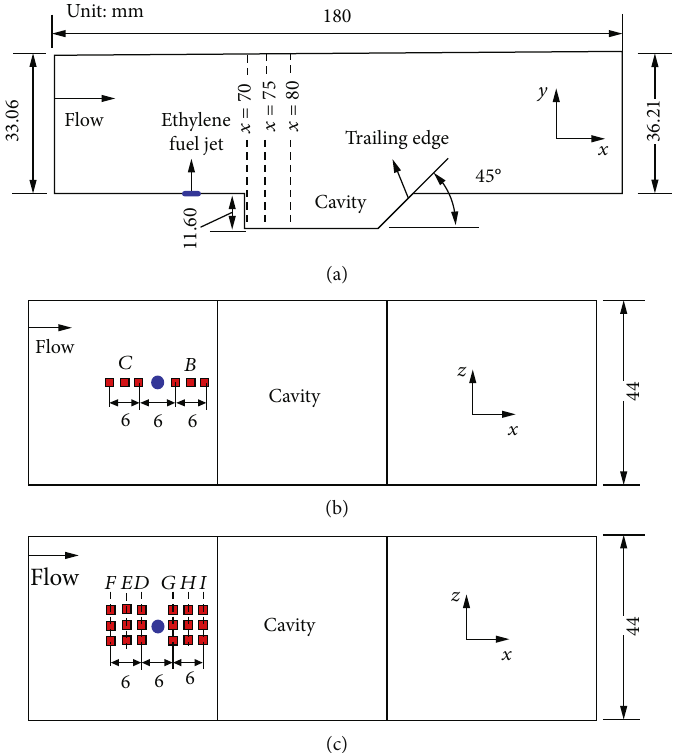
Figure 1: Schematic diagram of the physical model. (a) The physical model without energy deposition, from a side view. (b) The heating zones are arranged in the streamwise direction, from a top view. (c) The heating zones are arranged in the spanwise direction, from a top view.